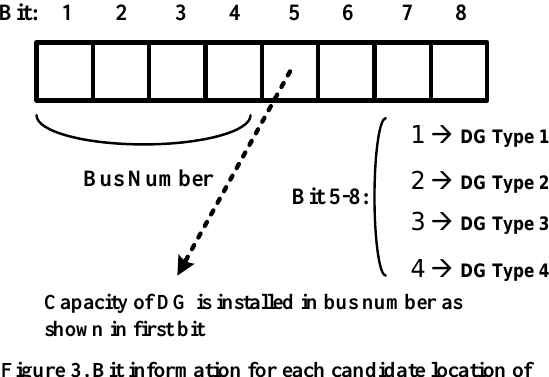
Figure 3. Bit information for each candidate location of DG.